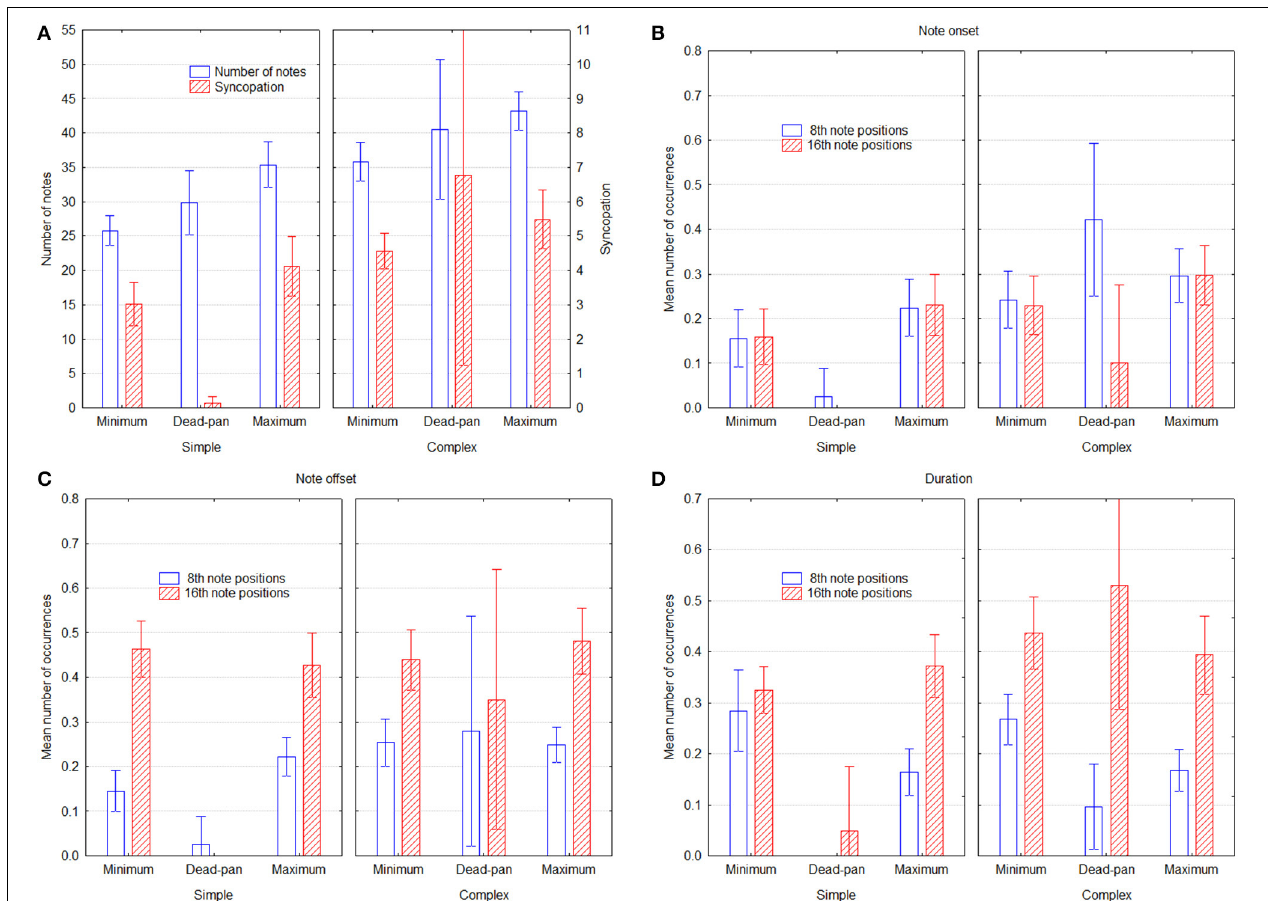
FIGURE 2 | Performance parameters as a function of groove condition and melody type, across performers. Panel (A) shows the number of notes and the SG syncopation estimate, Panels (B,C) show the mean proportion of